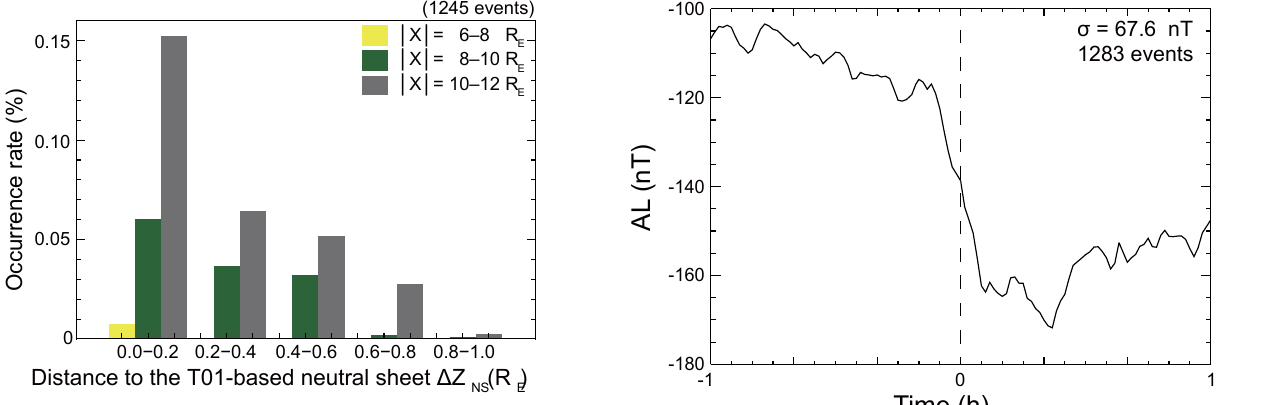
Figure 8. Occurrence rates of the fluctuation events with distance (cid:52) Z NS to the neutral sheet for the three subregions. Figure 9. Superposed epoch analysis of the AL index 1h before and